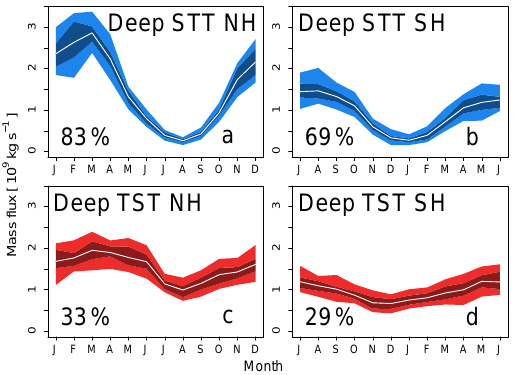
Fig. 8. Seasonal cycle of hemispherically integrated STT (blue, top) Fig. 9. Seasonal cycle of hemispherically integrated deep STT and TST (red, bottom) mass fluxes by all exchange events in the (blue, top) and deep TST (red, bottom) mass fluxes in the NH (left) NH (left) and SH (right) averaged from 1979 to 2011. The shading and SH (right) averaged from 1979 to 2011. The shading shows the shows the 5th and 95th (light) and the 25th and 75th (dark) per- 5th and 95th (light) and the 25th and 75th (dark) percentiles of the centiles of the monthly values, and the solid white line is the mean monthly values, and the solid white line is the mean value of the value of the 33yr. The seasonality is quantified by S = max − min 33yr. The seasonality is quantified and displayed as in Fig. , max + min where max and min denote the maximum and minimum value of the mean cycle. Percentages of S are shown in the individual plots.